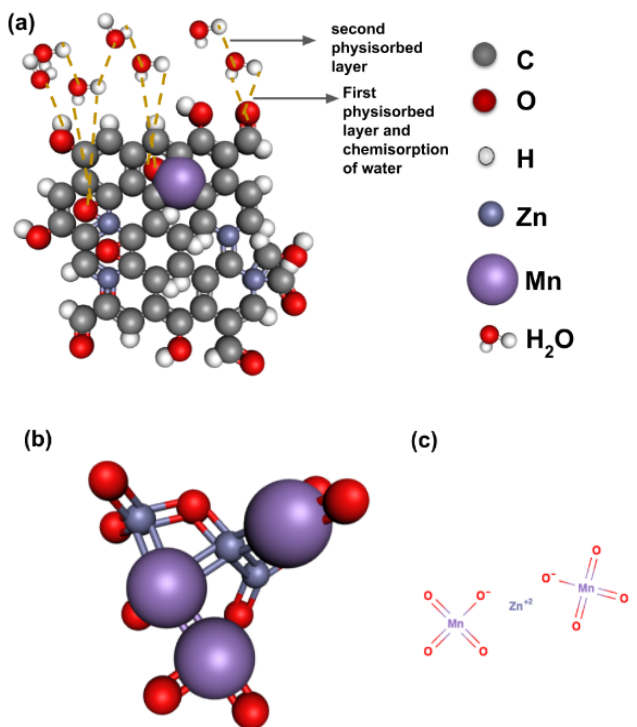
Figure 13. ( a ) Structure of GO deformation with Zn and Mn dopants in the nanocomposite GO- Zn 1 − x Mn x O with oxygen-rich groups and tailored defects enhancing water absorption. ( b ) Nucleation of Mn particles in the ZnMnO compound. ( c ) Dislodging of Zn by Mn atoms to increase states near the conduction band.